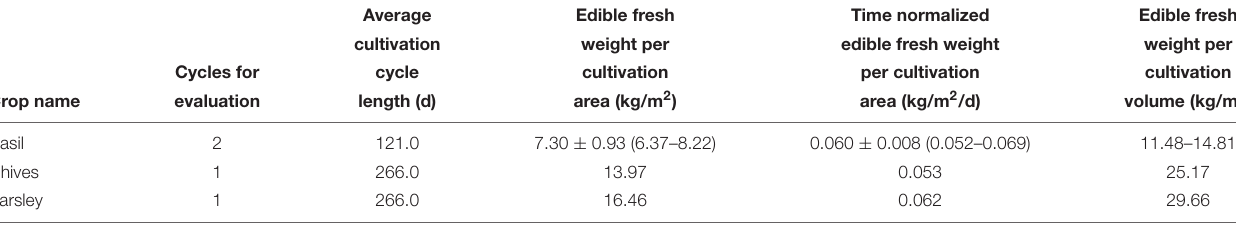
TABLE 7 | Herbs edible fresh weight production values.